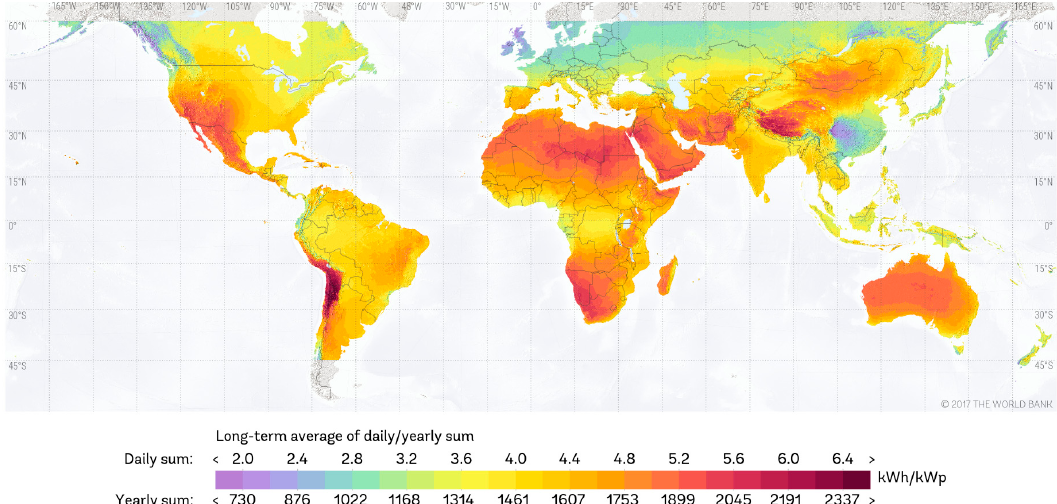
Figure 1. Photovoltaic Electricity Potential Map of World published by The World Bank Group [11].